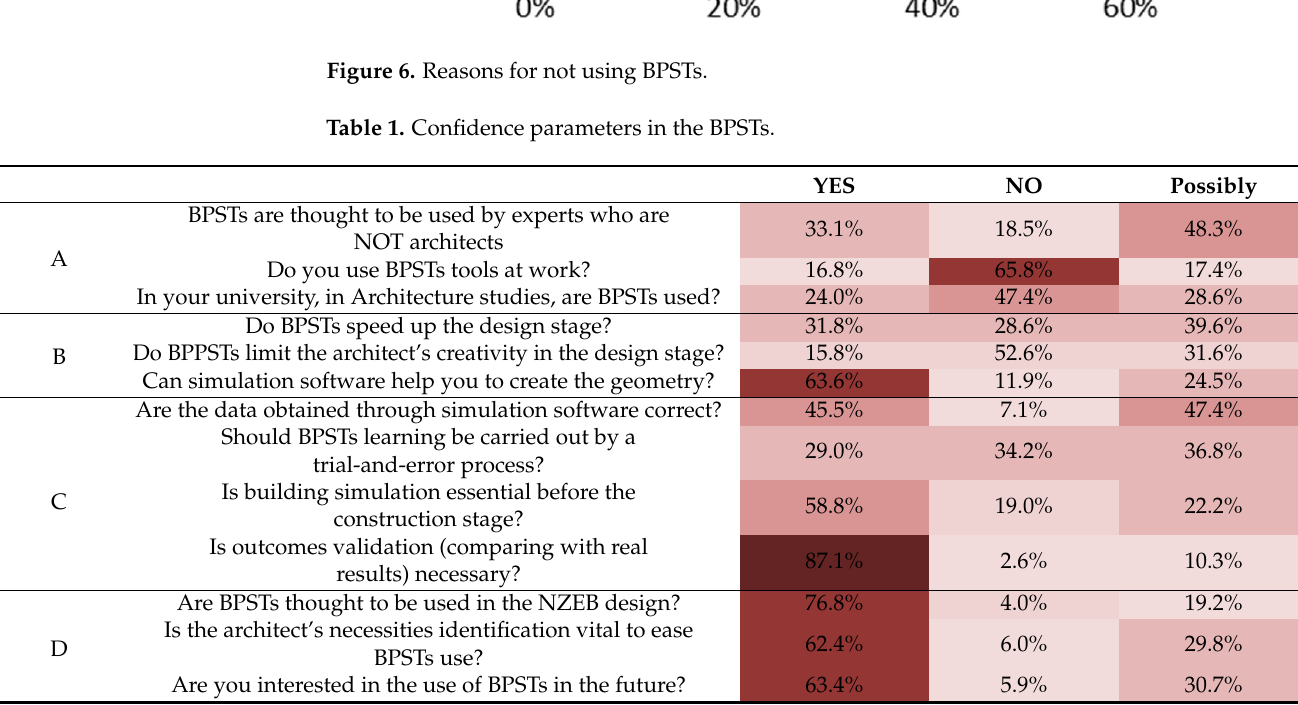
Figure 6. Reasons for not using BPSTs .